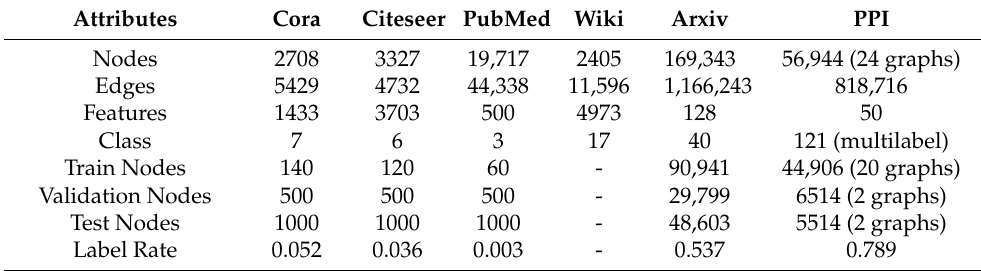
Table 1. Dataset